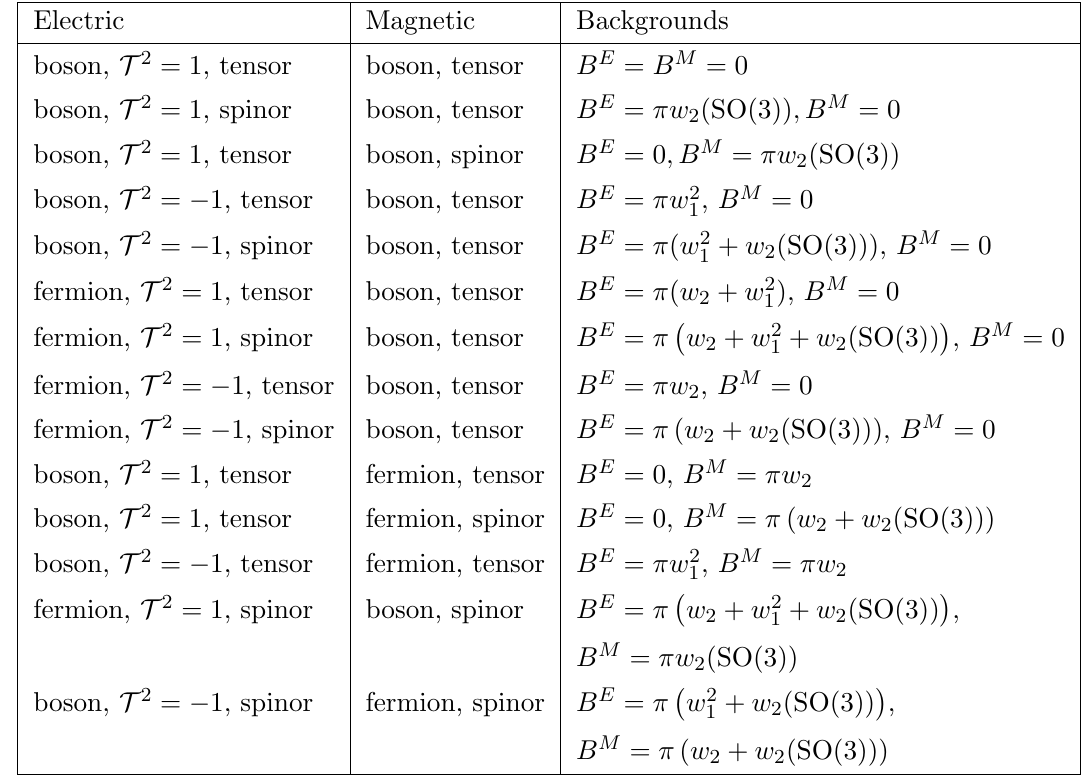
Table 4 . 14 non-anomlaous couplings of U(1) gauge theory at (cid:18) = 0 mod 2 (cid:25) to the backgrounds of SO(3) (cid:2) Z T symmetry. The electric particle has electric and magnetic charges (1 ; 0), while 2 the magnetic particle has charges (0 ; 1). The statistics, Kramer degeneracy and SO(3) projective representation (tensorial or spinorial representations, or equivalently integer or half-integer SU(2) isospin) of the particles are according to [32]. The di(cid:11)erent couplings correspond to di(cid:11)erent backgrounds for the electric and magnetic one-form